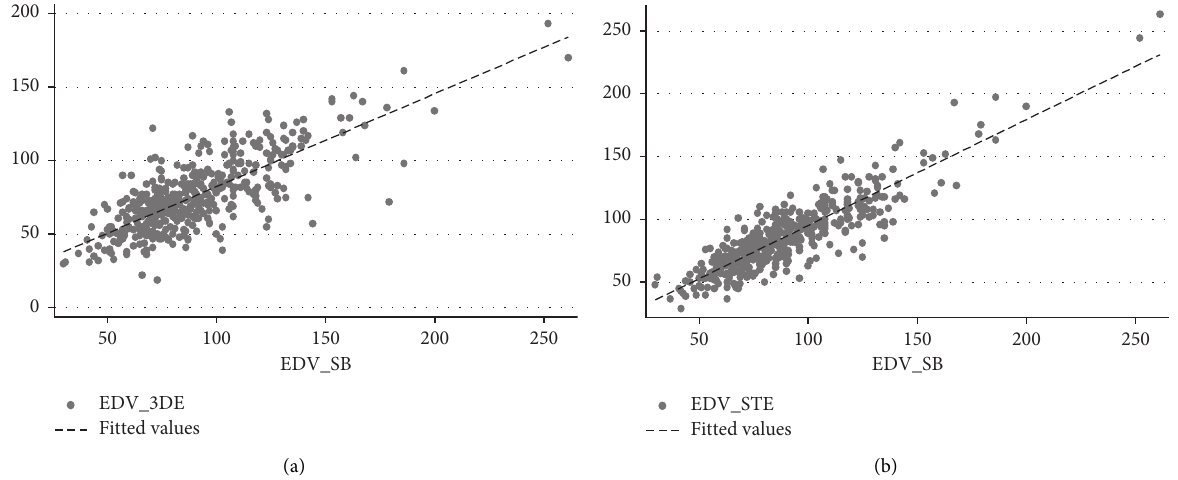
Figure 3: Simple linear regression analysis between EDV_3DE and EDV_SB (a) and EDV_STE and EDV_SB (b). EDV_3DE � 18.94 +0.63 EDV_SB. EDV_STE � 10.51+ 0.84 EDV_SB. 18.77Bland-Altman Plot of LVEF_ SB vs LVEF_3DE Bias 1.66; LOA: –15.45 to